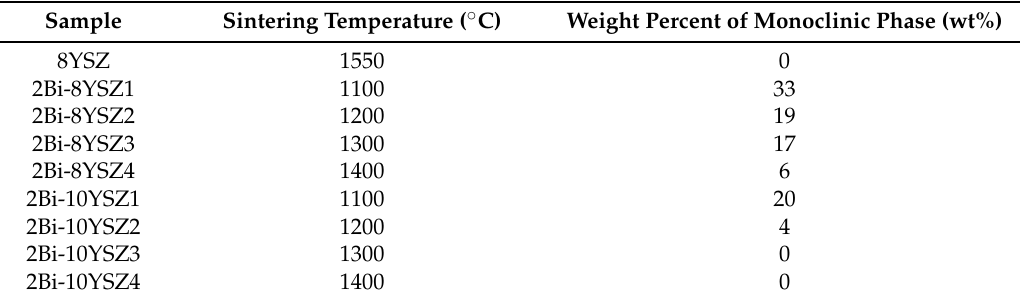
Figure 1. XRD pattern: ( a ) 8YSZ 1550 °C; ( b ) 2Bi-8YSZ 1100 °C; ( c ) 2Bi-8YSZ 1200 °C; ( d ) 2Bi-8YSZ 1300 °C; ( e ) 2Bi-8YSZ 1400 °C. Table 1. The weight percent of monoclinic phases of different samples.